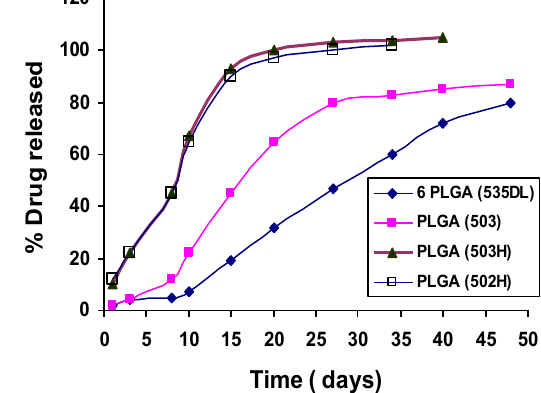
Figure 4: In vitro release of sertraline HCl from different polymer microspheres in acetate buffer pH 5 at